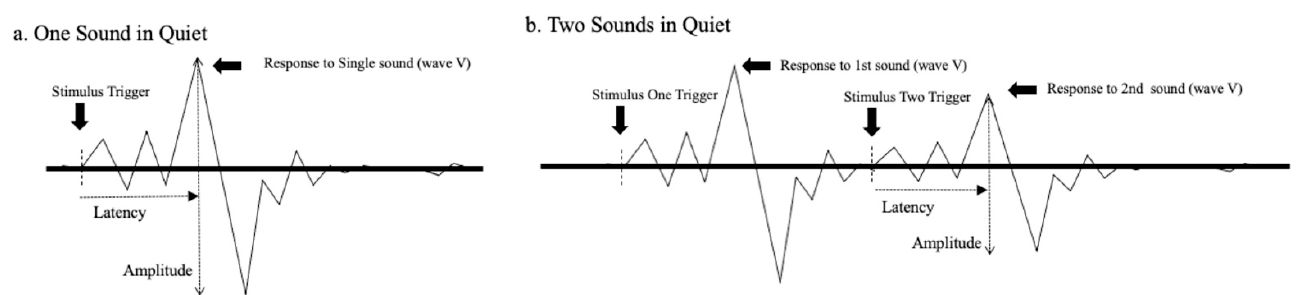
Figure 2. Simple diagrams of ABR waveforms evoked by a brief tone burst (panel a ) or successive tone bursts (panel b ). Major peaks of the responses are present and wave V is labeled. The measures of latency and amplitude of wave V are shown in each stimulus configuration. Latency is measured from the stimulus trigger to the peak’s maximum.